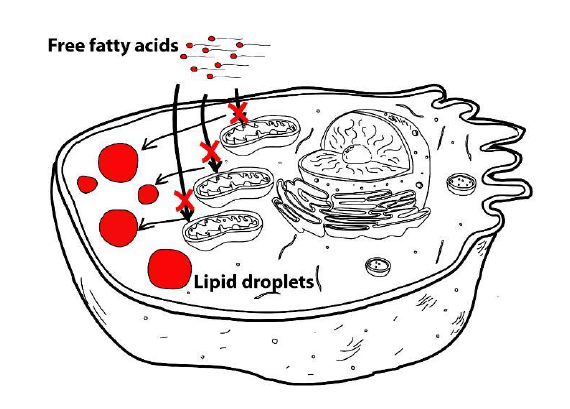
Figure 2: Impaired fatty acid oxidation in senescent cells leads to increased fat storage. Induction of cellular senescence induc- es mitochondrial dysfunction and impaired fatty acid oxidation, thus contributing to increased cytosolic fat accumulation (lipid